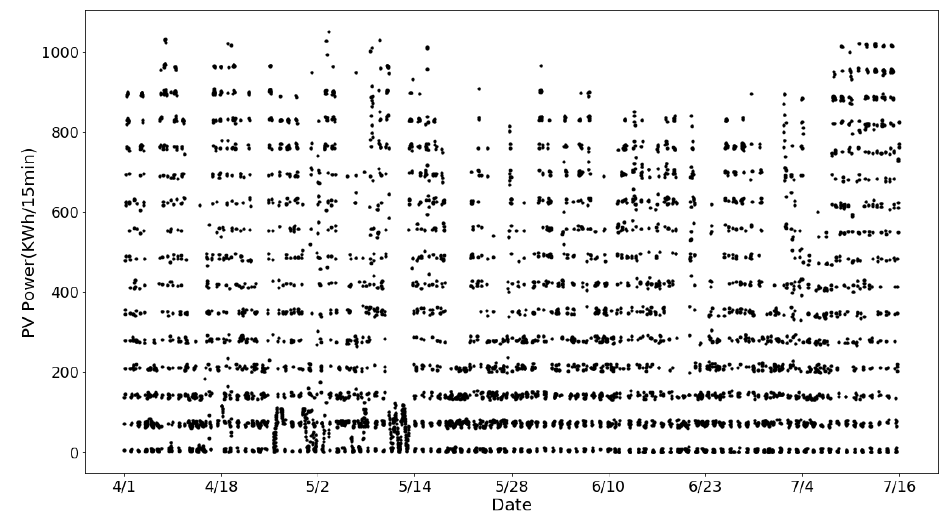
Figure 4. All measured PV power data.